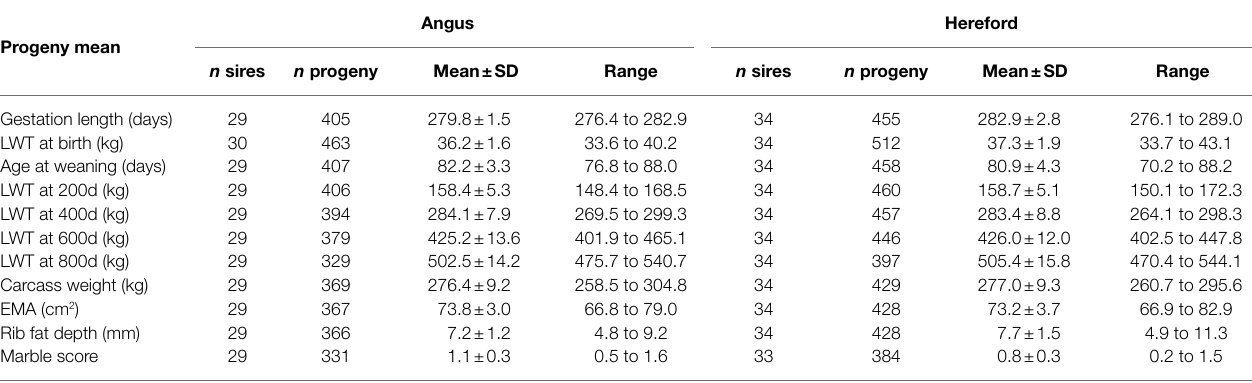
TABLE 2 | Number of sires and progeny, mean (± SD), and range of the least-squares means of beef-cross-dairy progeny groups for birth (gestation length and birthweight), growth (age at weaning and liveweight (LWT) at 200, 400, 600, and 800 days of age), and carcass traits (carcass weight, eye muscle area (EMA), rib fat depth, and marble score), for 30 Angus and 34 Hereford sires.